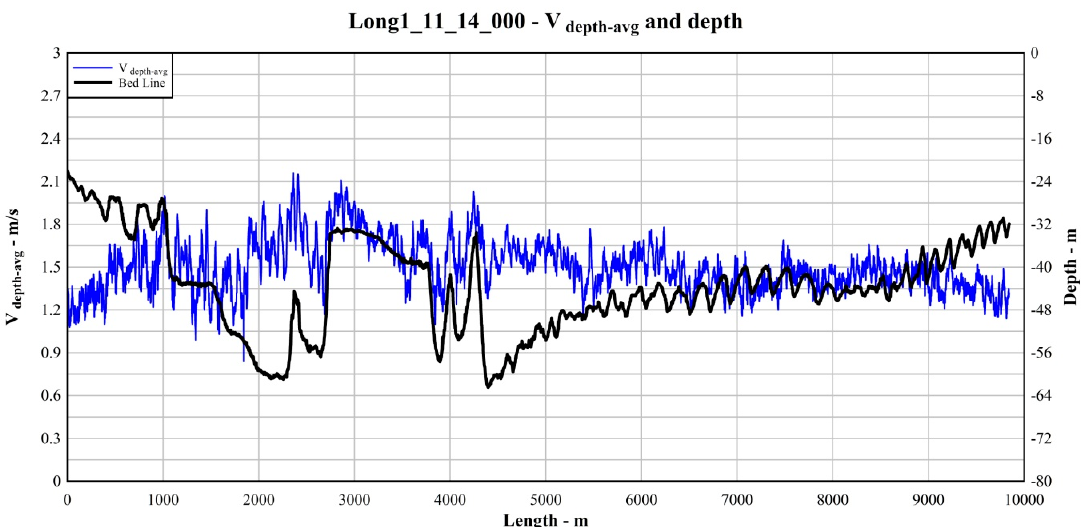
Figure 5. Depth-averaged velocity (blue) and bedline (black) for Long1_11_14_000 transect (FS − CNS1).